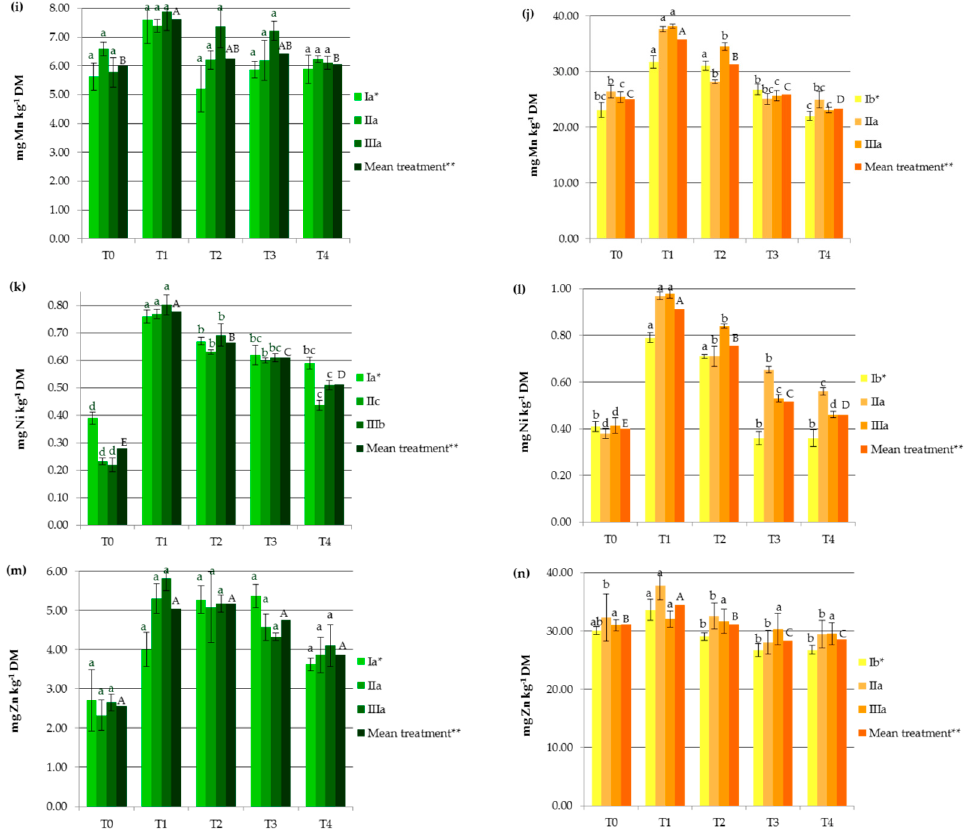
Figure 1. Impact of soil amendments on contents of heavy metals in hemp straw: ( a ) Cd, ( c ) Cr, ( e ) Cu, ( g ) Fe, ( i ) Mn, ( k ) Ni, ( m ) Zn, and inflorescences ( b ) Cd, ( d ) Cr, ( f ) Cu, ( h ) Fe, ( j ) Mn, ( l ) Ni, ( n ) Zn. T0: the control without fertilization, T1: 170 kg N ha − 1 from sewage sludge, T2: 170 kg N ha − 1 from sewage sludge and 100 kg ha − 1 of phosphogypsum, T3: 170 kg N ha − 1 from sewage sludge and 500 kg ha − 1 of phosphogypsum, T4: 170 kg N ha − 1 from sewage sludge and 1000 kg ha − 1 of phosphogypsum, I: cv. Białobrzeskie, II: cv. Tygra, III: cv. Beniko. * means of varieties regardless of treatments; ** means of treatments regardless of cultivars. Bars with the same letter are not significantly different (capital letters indicate differences among the means of treatments regardless of cultivars).